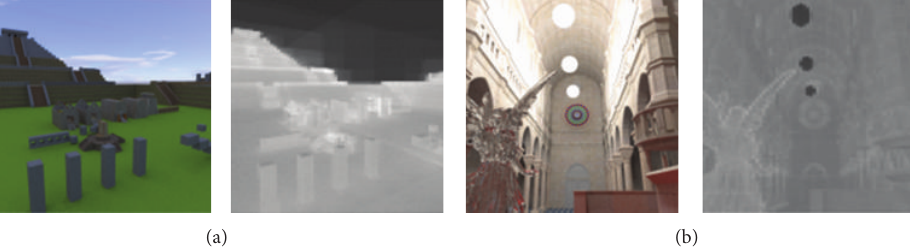
Figure 10: Render cost visualized: pixels representing the sky dome or light sources have a significant lower cost than other pixels. Cost is represented by greyscale values (brighter is higher cost), per 32 pixels (a full warp). Measured using a tracer implemented in NVidia’s CUDA [11] for two scenes: Aztec (a) and Sibenik Cathedral